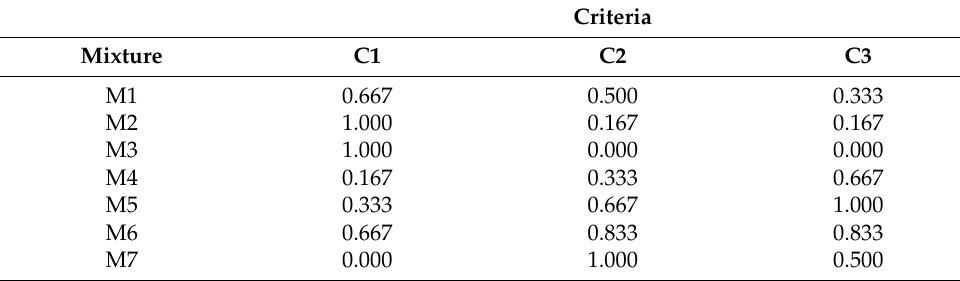
Table A3. Normalized decision matrix for the CoCoSo method.